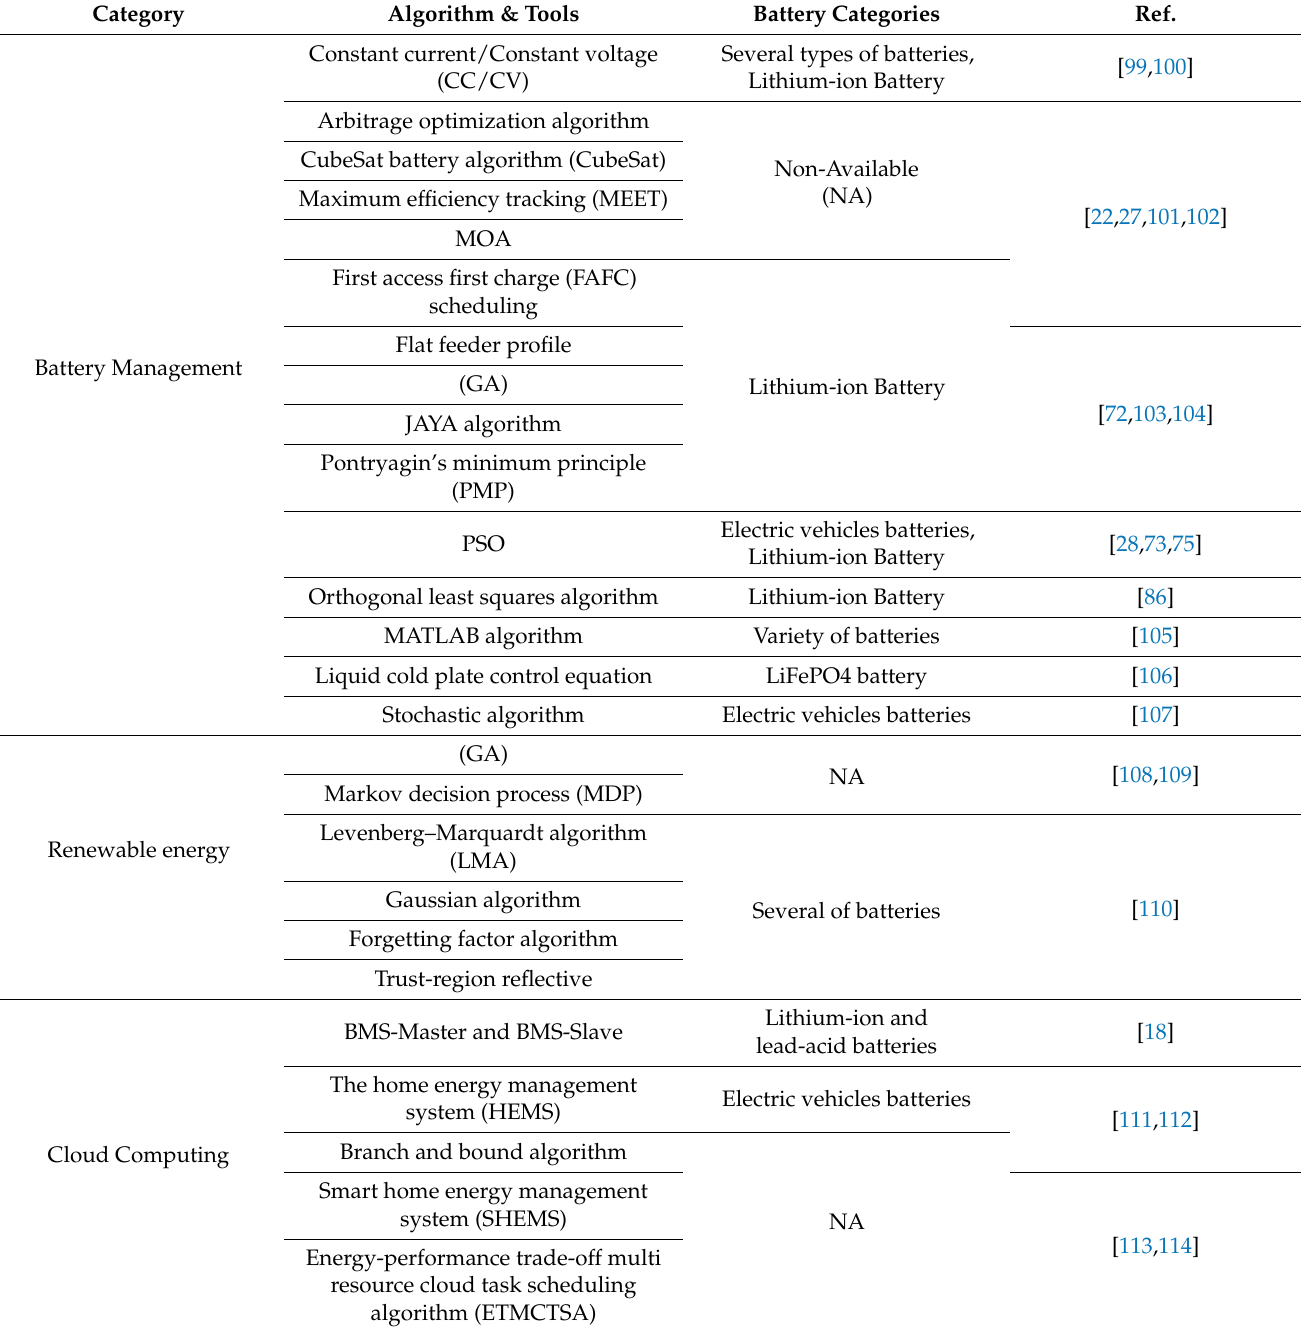
Table 1. Summary of the literature algorithms of battery management, renewable energy, and cloud computing.